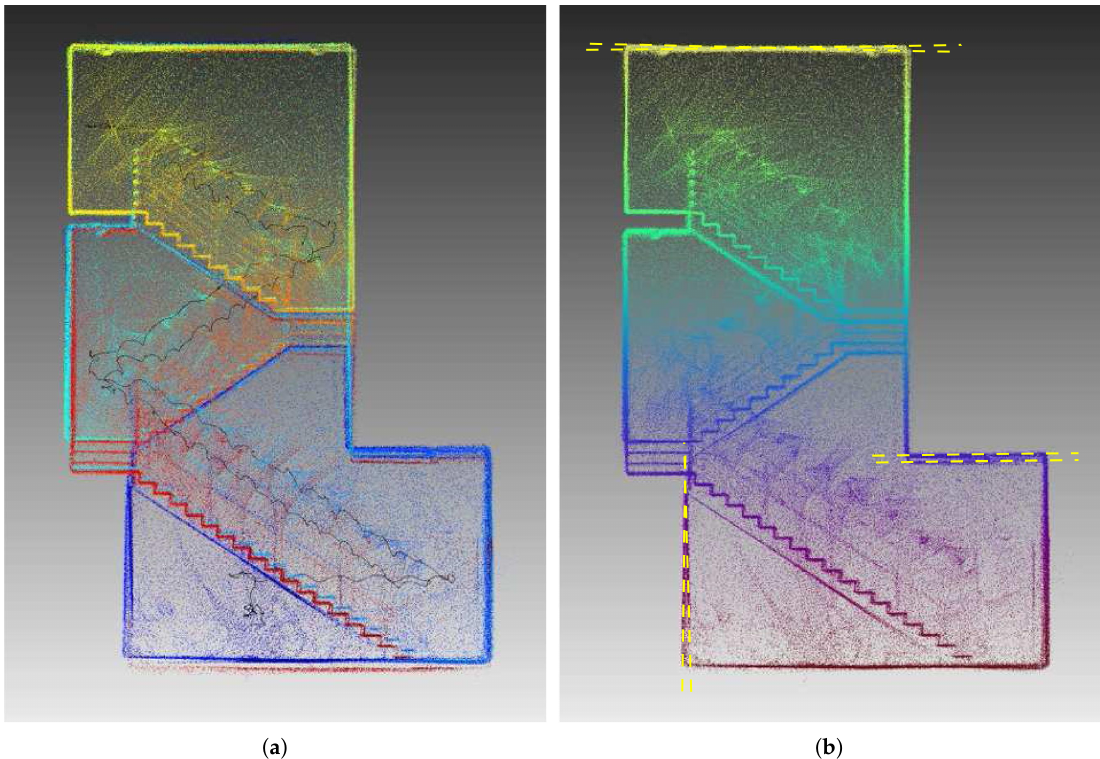
Figure 3. “Double walls” error in the reconstruction of Zebedee [5]. The wall and the ceiling appears twice in the reconstruction, causing an ambiguity. In the solution without loop closure ( a ), the error is quite visible. Double walls are reduced after global loop closure ( b ), but they are still present (highlighted by yellow dashed